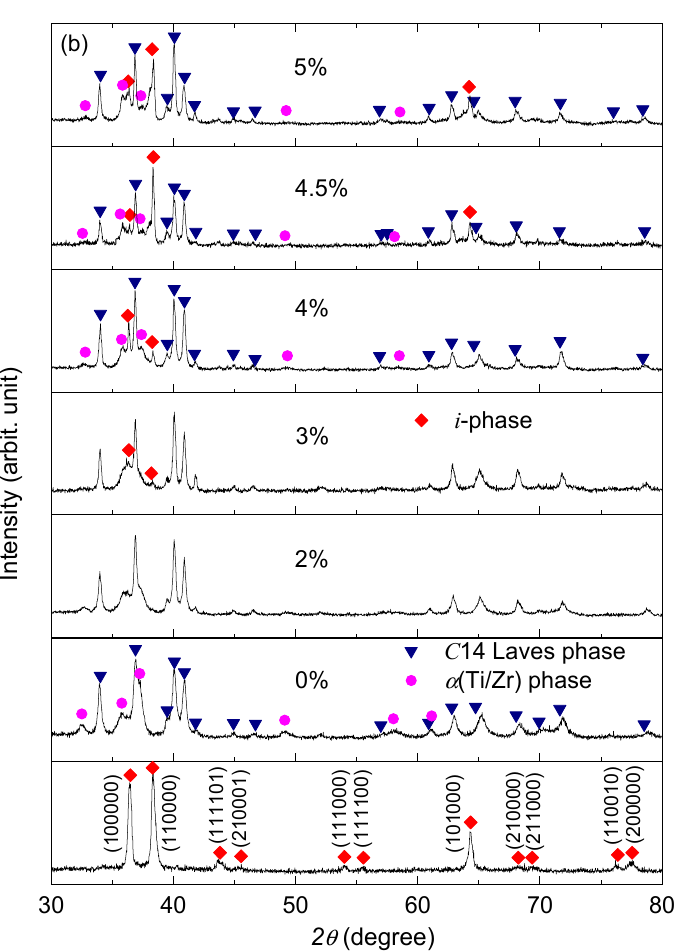
Figure 4. ( a ) Temperature-time profiles of (Ti 35.2 Zr 43.8 Ni 21 ) 100 − x Ag x alloy liquids in the ESL experiment. ( b ) XRD patterns of (Ti 35.2 Zr 43.8 Ni 21 ) 100 − x Ag x alloys processed by ESL. The i -phase, C 14 Laves, and α (Ti/Zr) phases were marked by diamonds ( ◆ ), triangles ( ▼ ), and circles ( ● ), respectively.